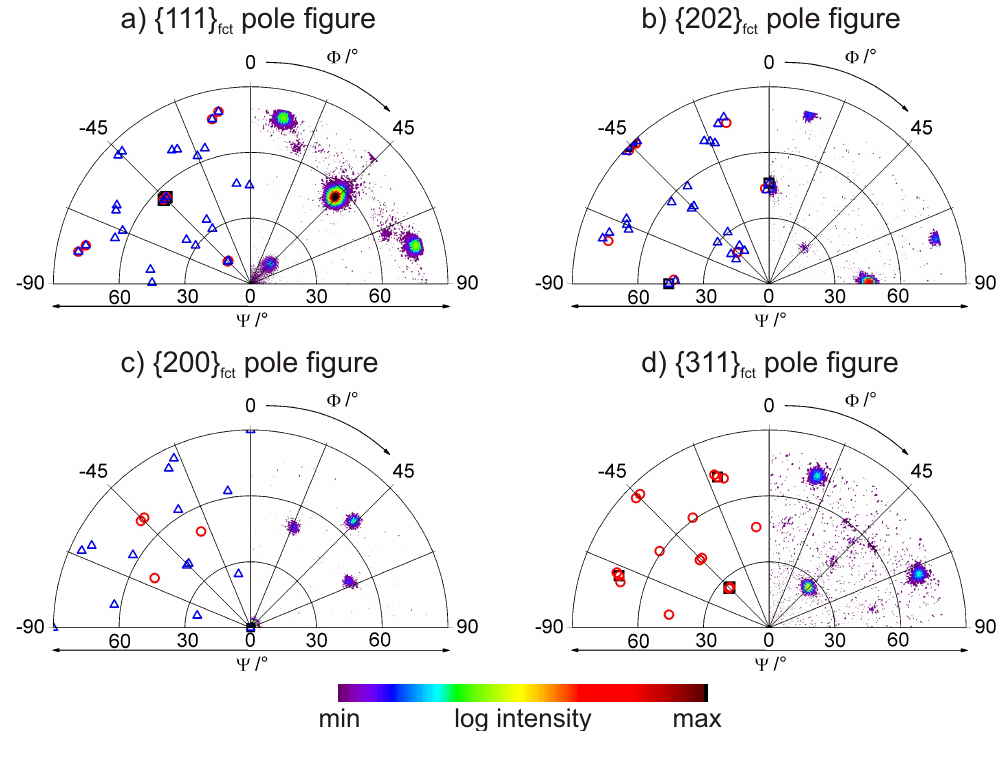
Figure 5. Comparison of the measured pole figure of the Fe (cid:104) 112 (cid:105) twins (left quadrant) of ( a ) { 111 } simulations of fcc-type { 111 } fct fct { 200 } and ( d ) { 311 } . Black squares represent the epitaxial matrix, red circles the first fct fct twin generation and the blue triangles, the second twin